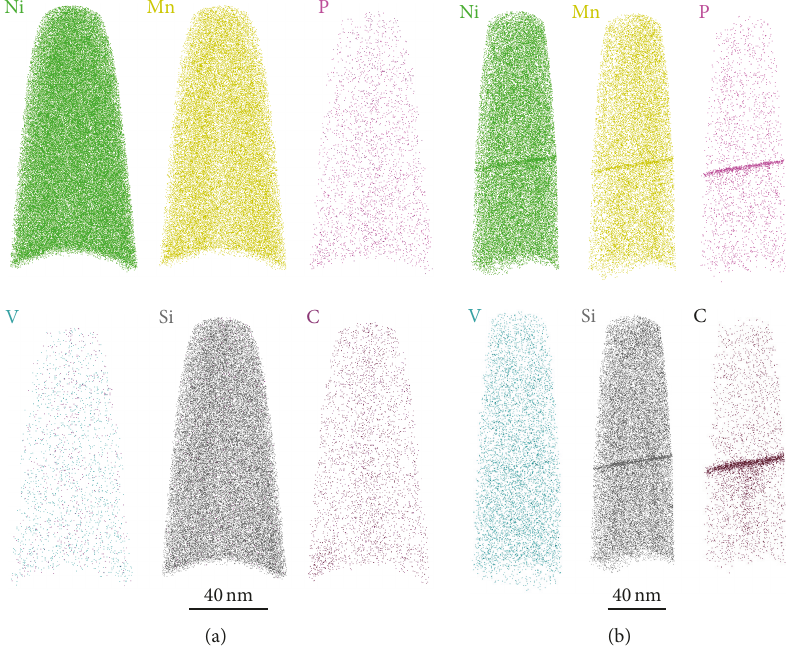
Figure 4: 3D mapping of Ni, Mn, P, V, Si, and C in the steel obtained by APT: as-received specimen (a) and after segregation provoking treatment (b).